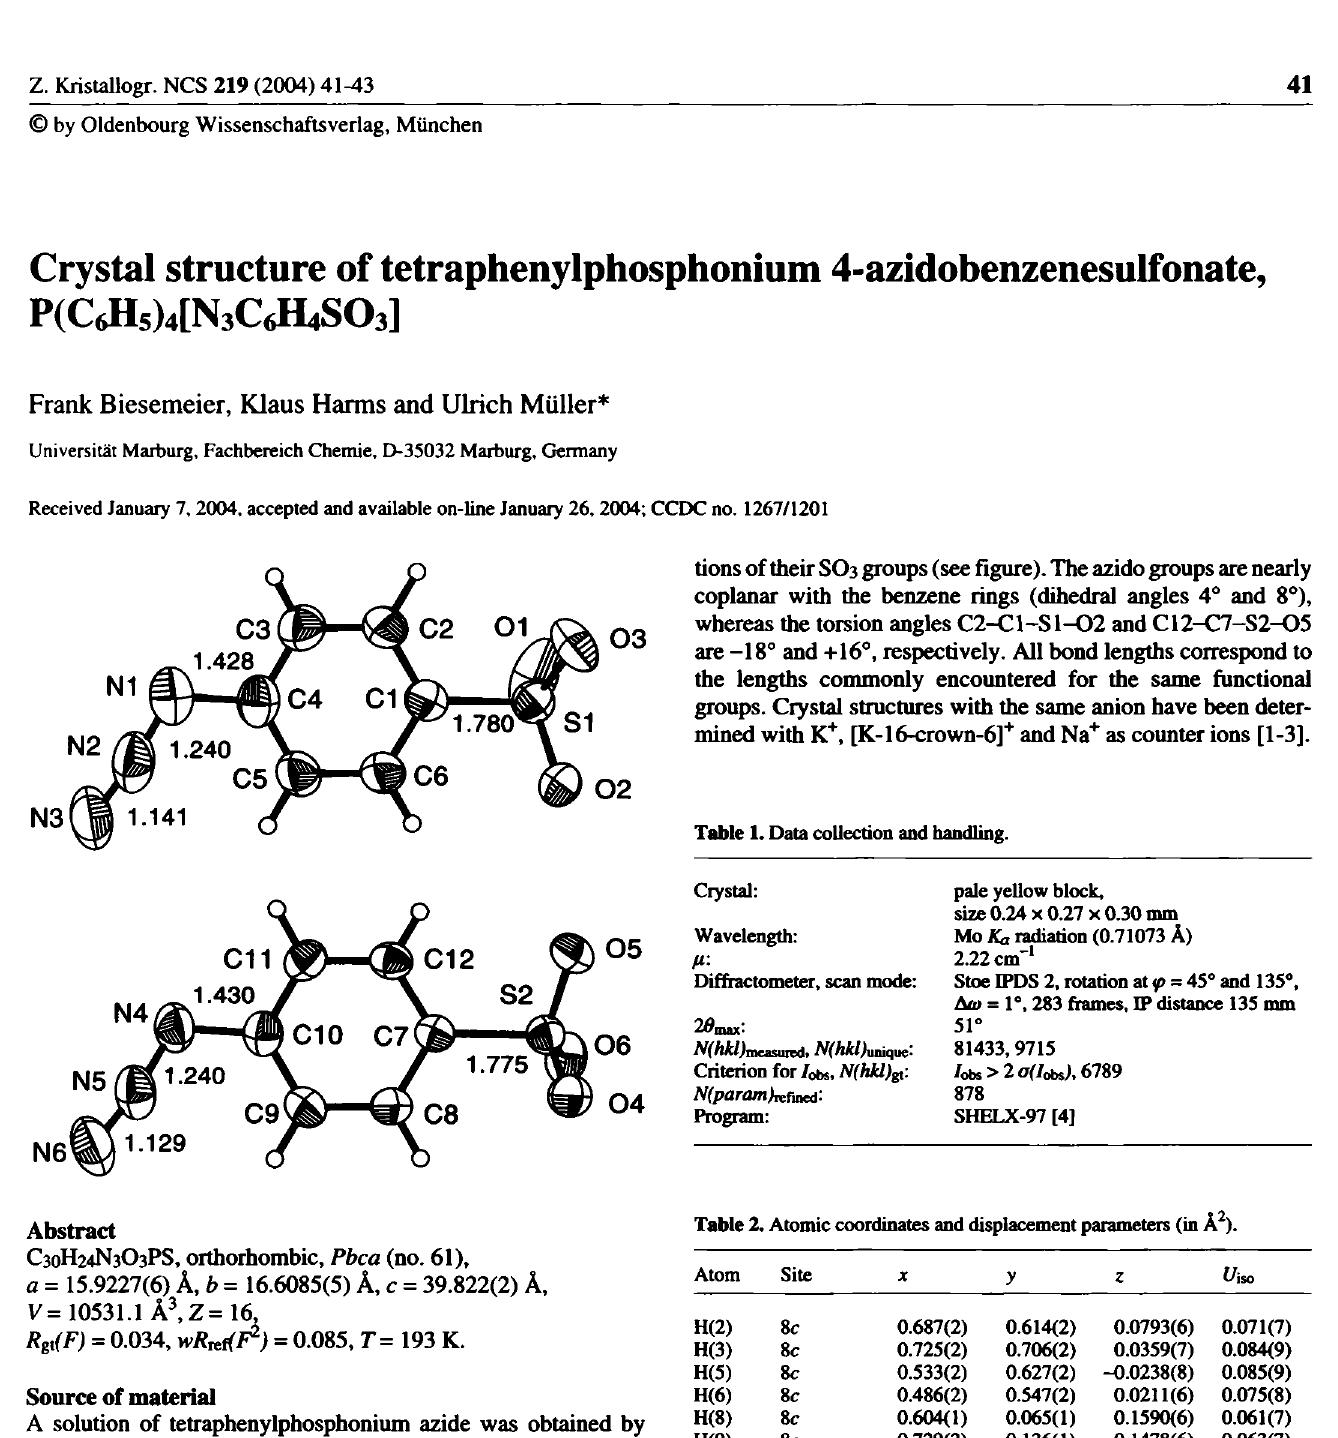
Table 2. Atomic coordinates and displacement parameters (in Â 2